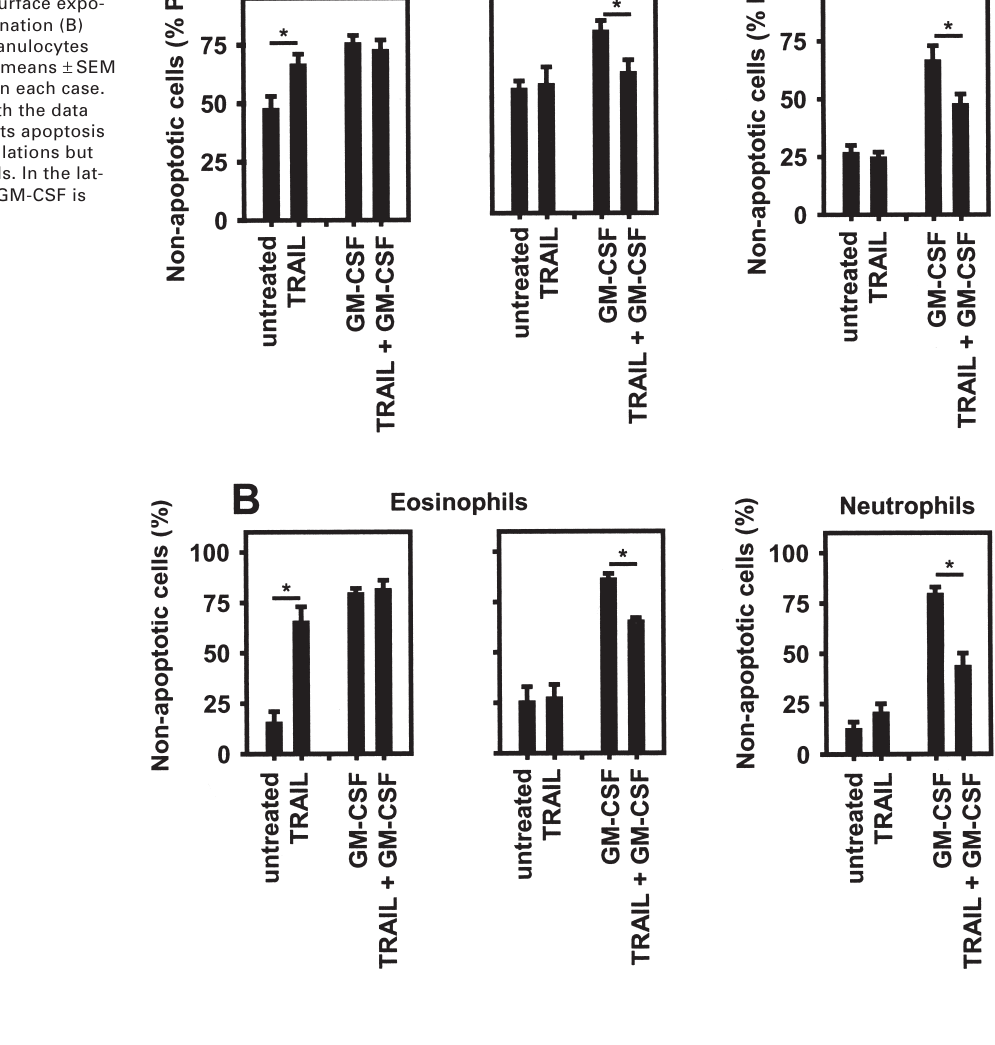
Apoptosis regulation by TRAIL in granulocytes in vitro. Phosphatidylserine (PS) surface expo- sure (A) and morphological examination (B) were used to detect apoptosis. Granulocytes were cultured for 24 h. Values are means ± SEM of four independent experiments in each case. * p <0.05. The results correlate with the data presented in figure 3. TRAIL inhibits apoptosis in a proportion of eosinophil populations but not in others and not in neutrophils. In the lat- ter, however, survival induced by GM-CSF is partially inhibited by